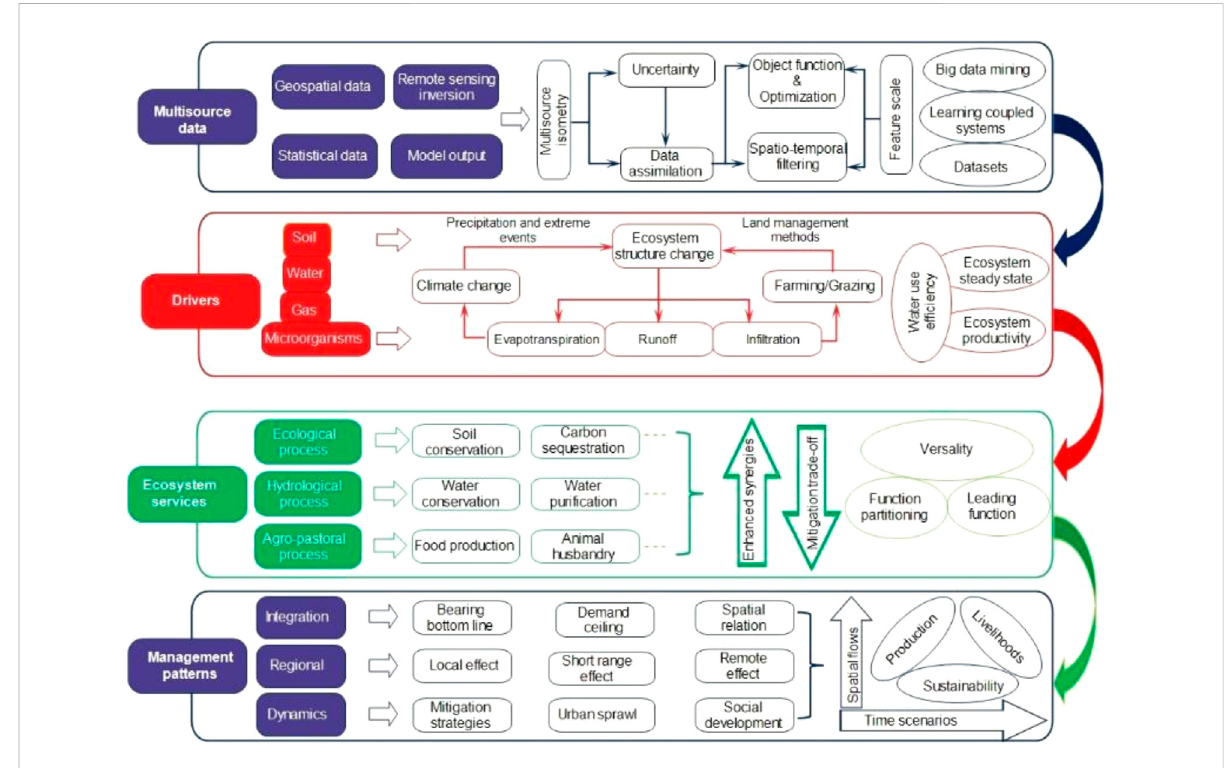
FIGURE 6 Research directions of climate change, dryland variation, and food security